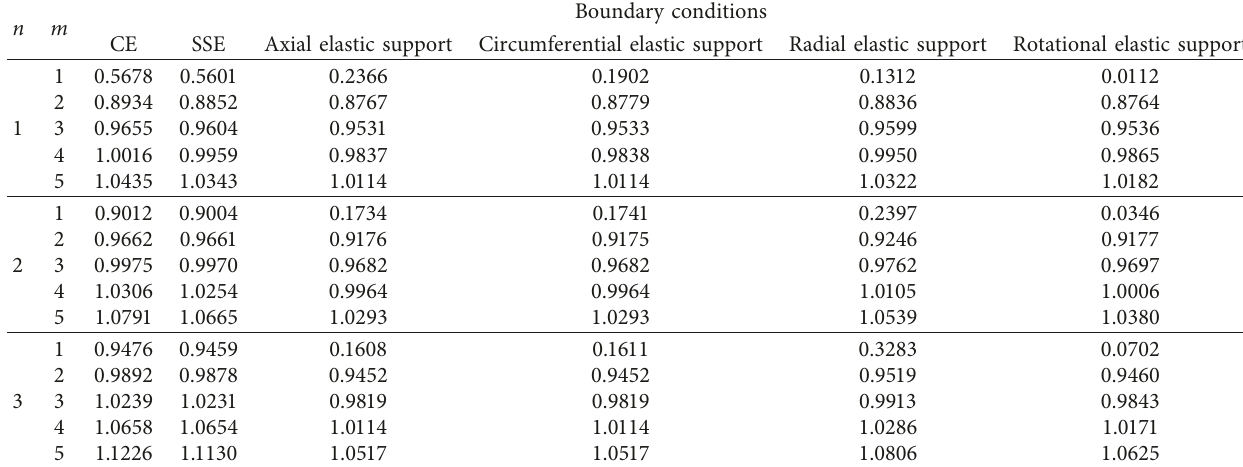
Table 6: Nondimensional frequency parameter of uniform hemispherical cap with different edge conditions.